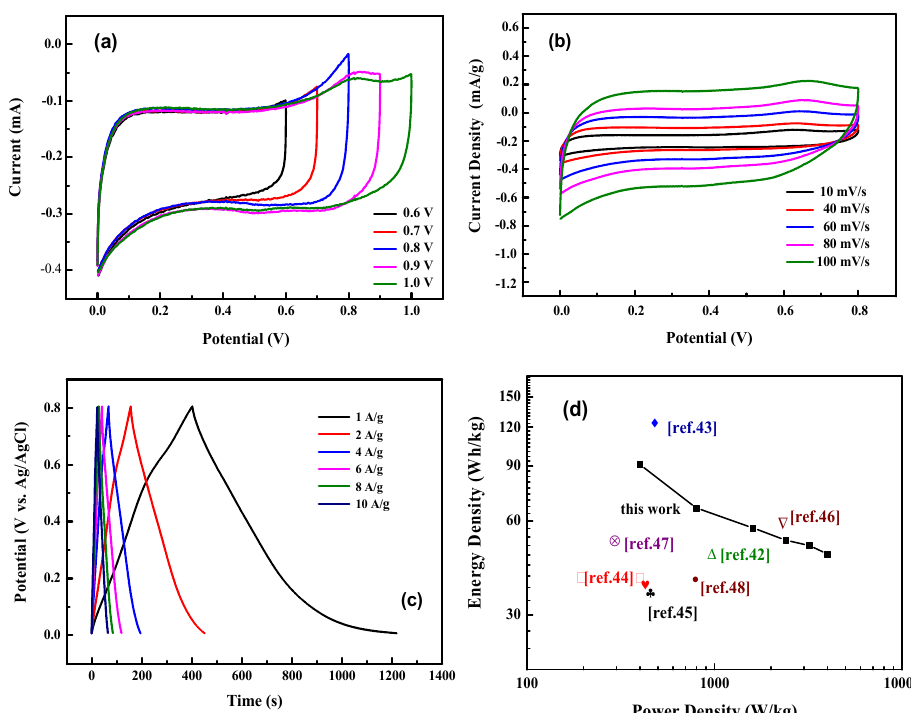
Figure 7. The electrochemical performance of the as-assembled MnO 2 /graphene//graphene asym- metric supercapacitor: ( a ) the CV curves of the as-obtained MnO 2 /graphene//graphene asymmetric supercapacitor scan at various scan rates ( b ); the GCD test of the assembled asymmetric superca- pacitor ( c ); and the Ragone plots of the MnO 2 /graphene//graphene asymmetric supercapacitor( d ).